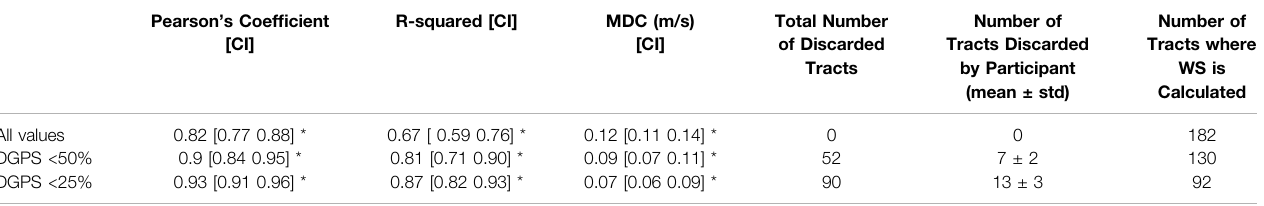
Frontiers in Bioengineering and Biotechnology |